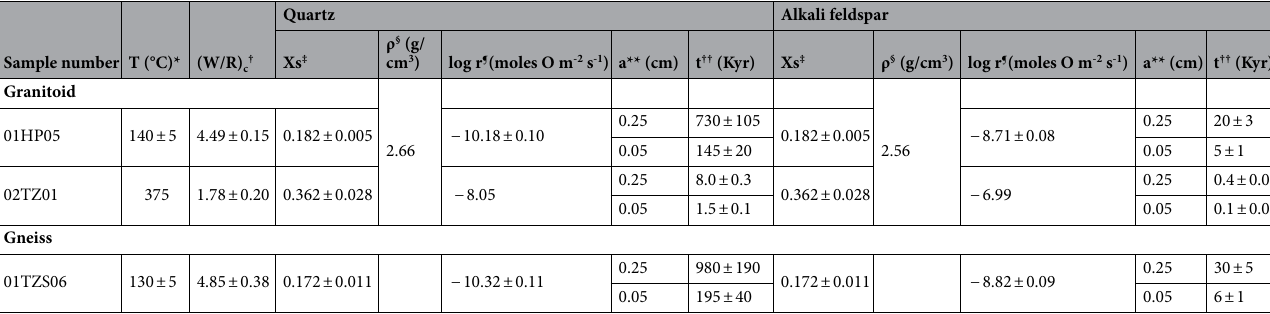
Table 2. Parameters of surface-reaction oxygen exchange. *Re-equilibration temperature from Table 1. † Closed system (W/R) ‡ Mole fraction of mineral oxygen re-equilibrated with a c ratio refers to Figs. S1–S3. water. § Mineral density from Ref. 48 . ¶ Rate constant after Refs. 39,42 . **Grain radius. †† Time required for attaining 99% oxygen exchange (i.e., F value in the following equation) between a spherical mineral and water. As − ln ( 1 − F ) × ( W / R ) c × X s × a × ρ previously formulated for the closed system 39,42 , t = , where all variables are listed in 3 × [1 + ( W / R ) c ] × r × 10 − 4 Table 2 for corresponding